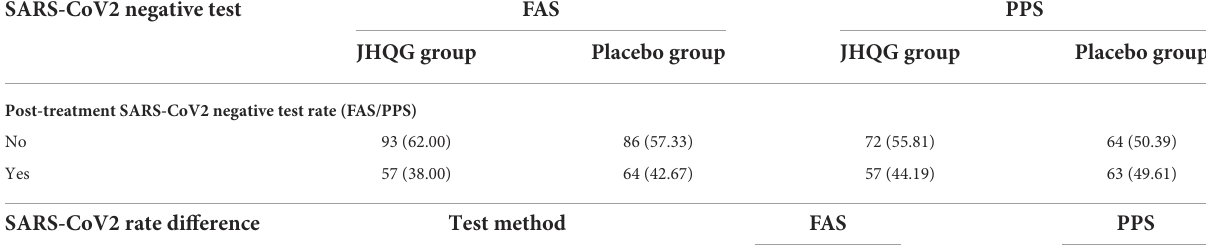
TABLE 4 Post-treatment SARS-CoV2 negative test rate (FAS/PPS), test rate difference, and Inter group comparison (FAS/PPS). SARS-CoV2 negative test